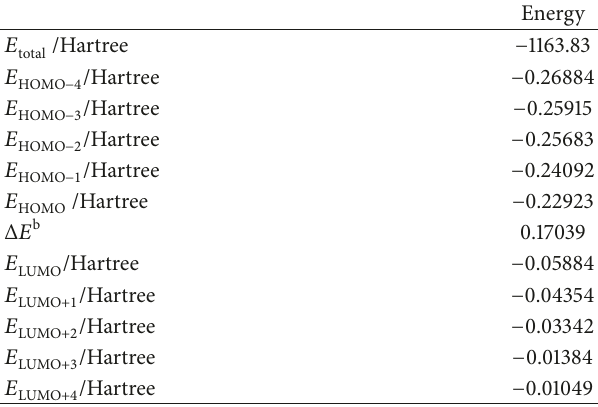
Table 4: Total energy and frontier orbital energy a